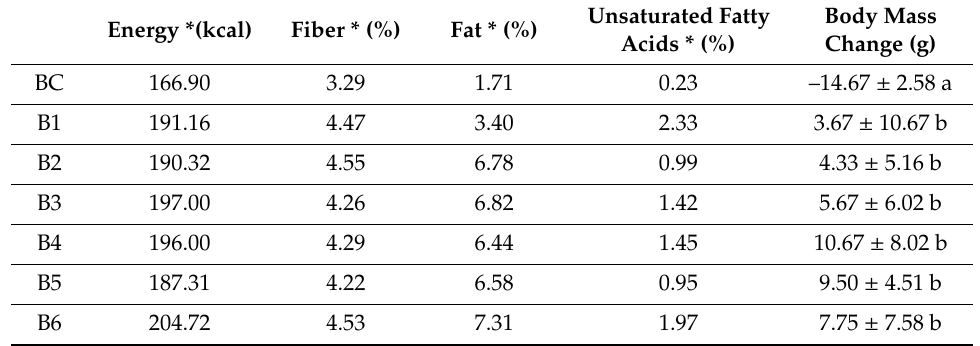
Table 2. Approximate energy, fiber, fat, and unsaturated fatty acids intake and mean body mass in rats. Energy